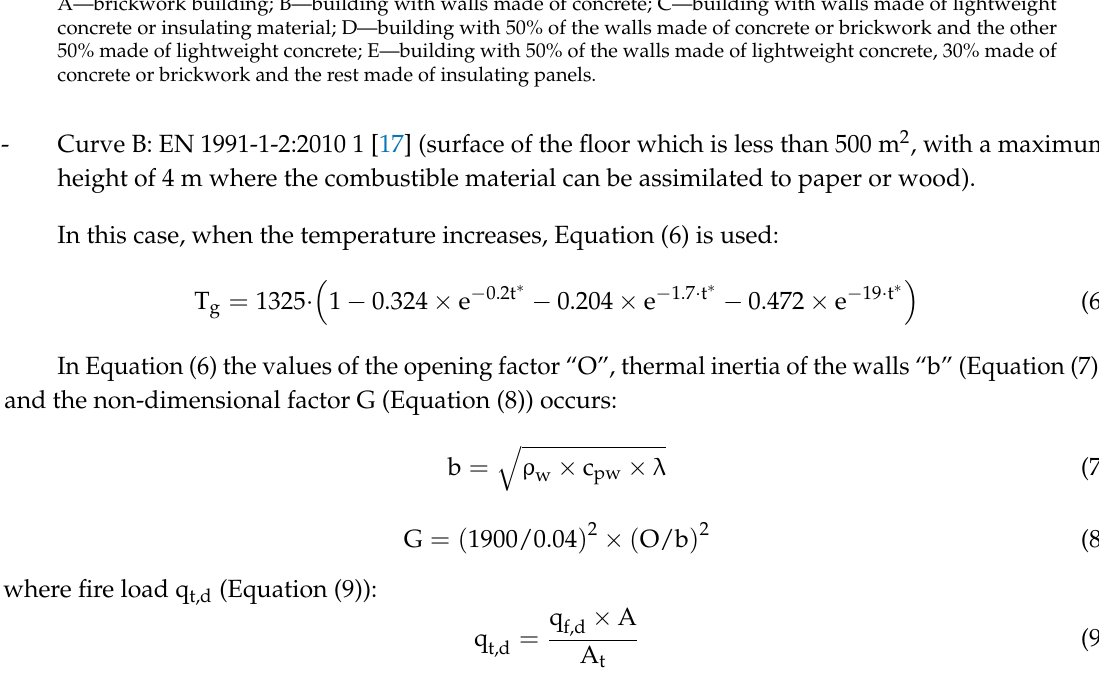
- Curve B: EN 1991-1-2:2010 1 [17] (surface of the floor which is less than 500 m 2 , with a maximum height of 4 m where the combustible material can be assimilated to paper or